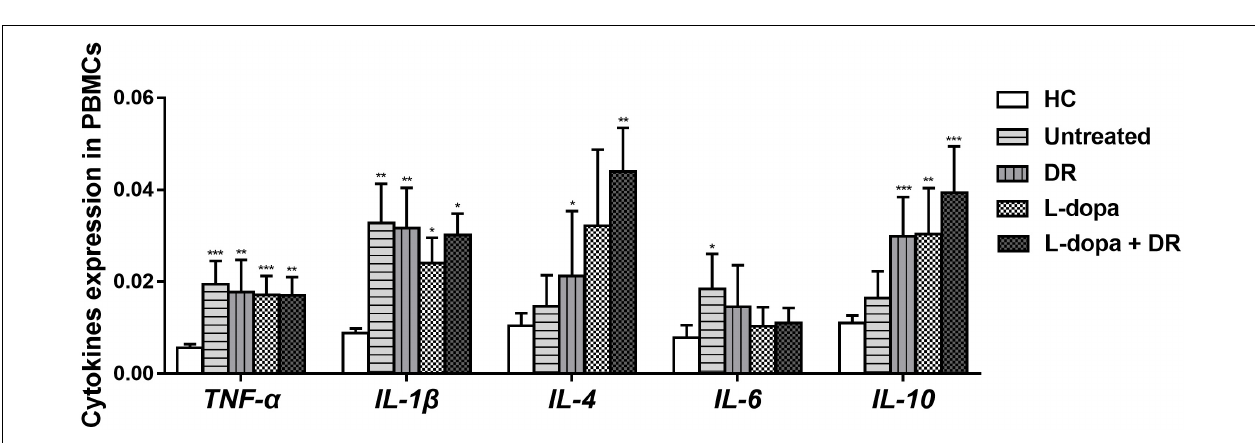
FIGURE 4 | The levels of TNF- α , IL-1 β , IL-4 , IL-6, and IL-10 expression in PD patients with different anti-PD medications. The results are the mean ± SEM values. ∗ p < 0.05, ∗∗ p < 0.01, and ∗∗∗ p < 0.001 relative to HC. DR: DA receptor agonists monotherapy; L-dopa: l-dopa monotherapy; L-dopa+DR: combination of DA agonists and